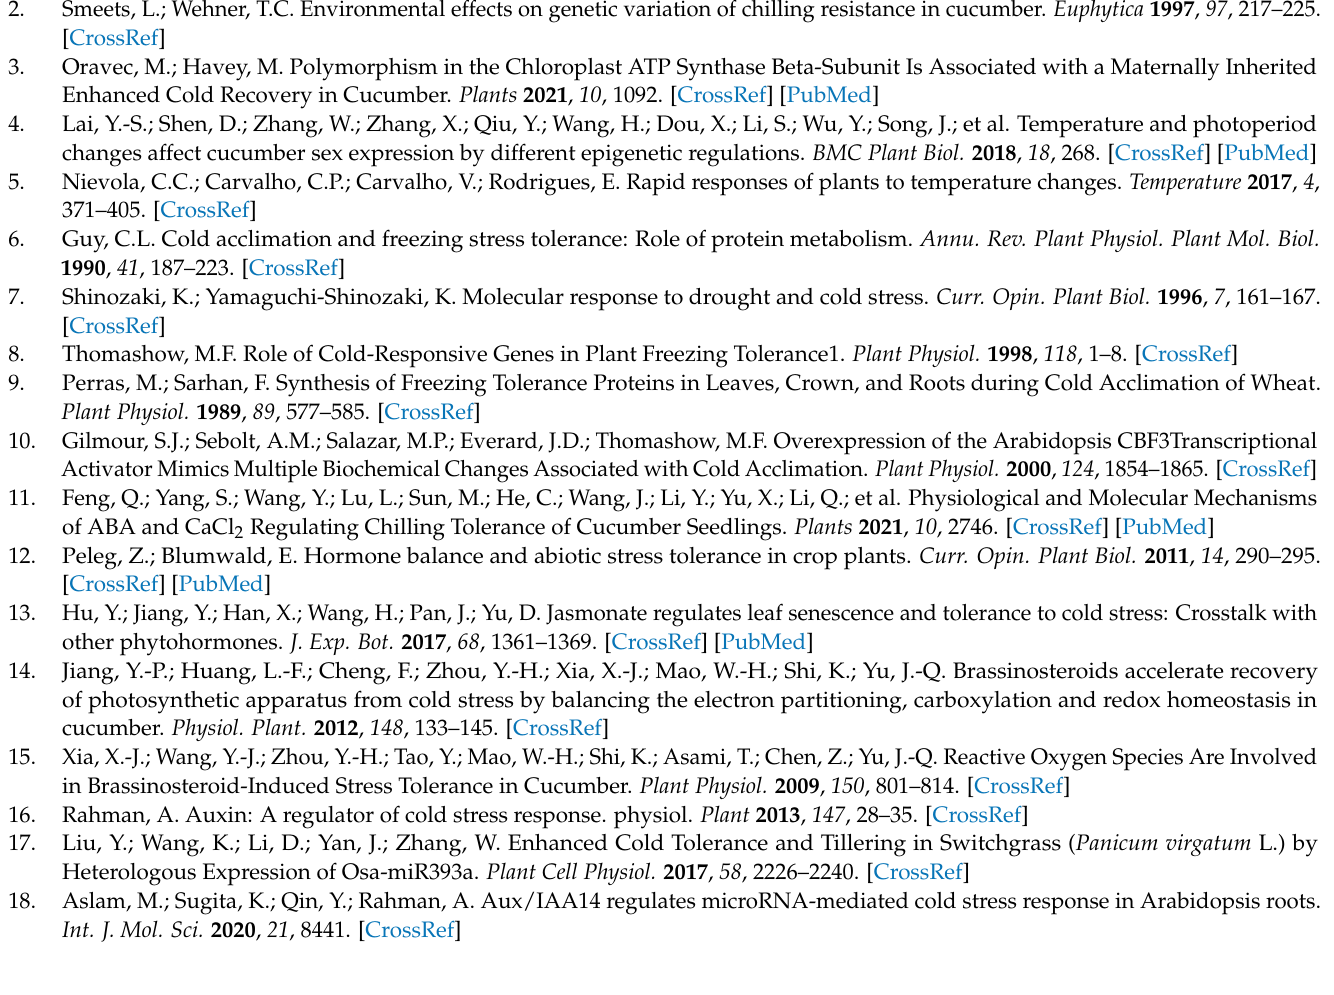
mosomes. Figure S2: GO classification of DEGs. Figure S3: Temperature decreased during the cold treatment in winter. Table S1: Cold tolerance of cucumber inbred lines. Table S2: Raw data of RNA-seq. Table S3: New genes identified in transcriptome assemblies. Table S4: The standard curve in plant hormone detection. Table S5: Quantity control in plant hormone